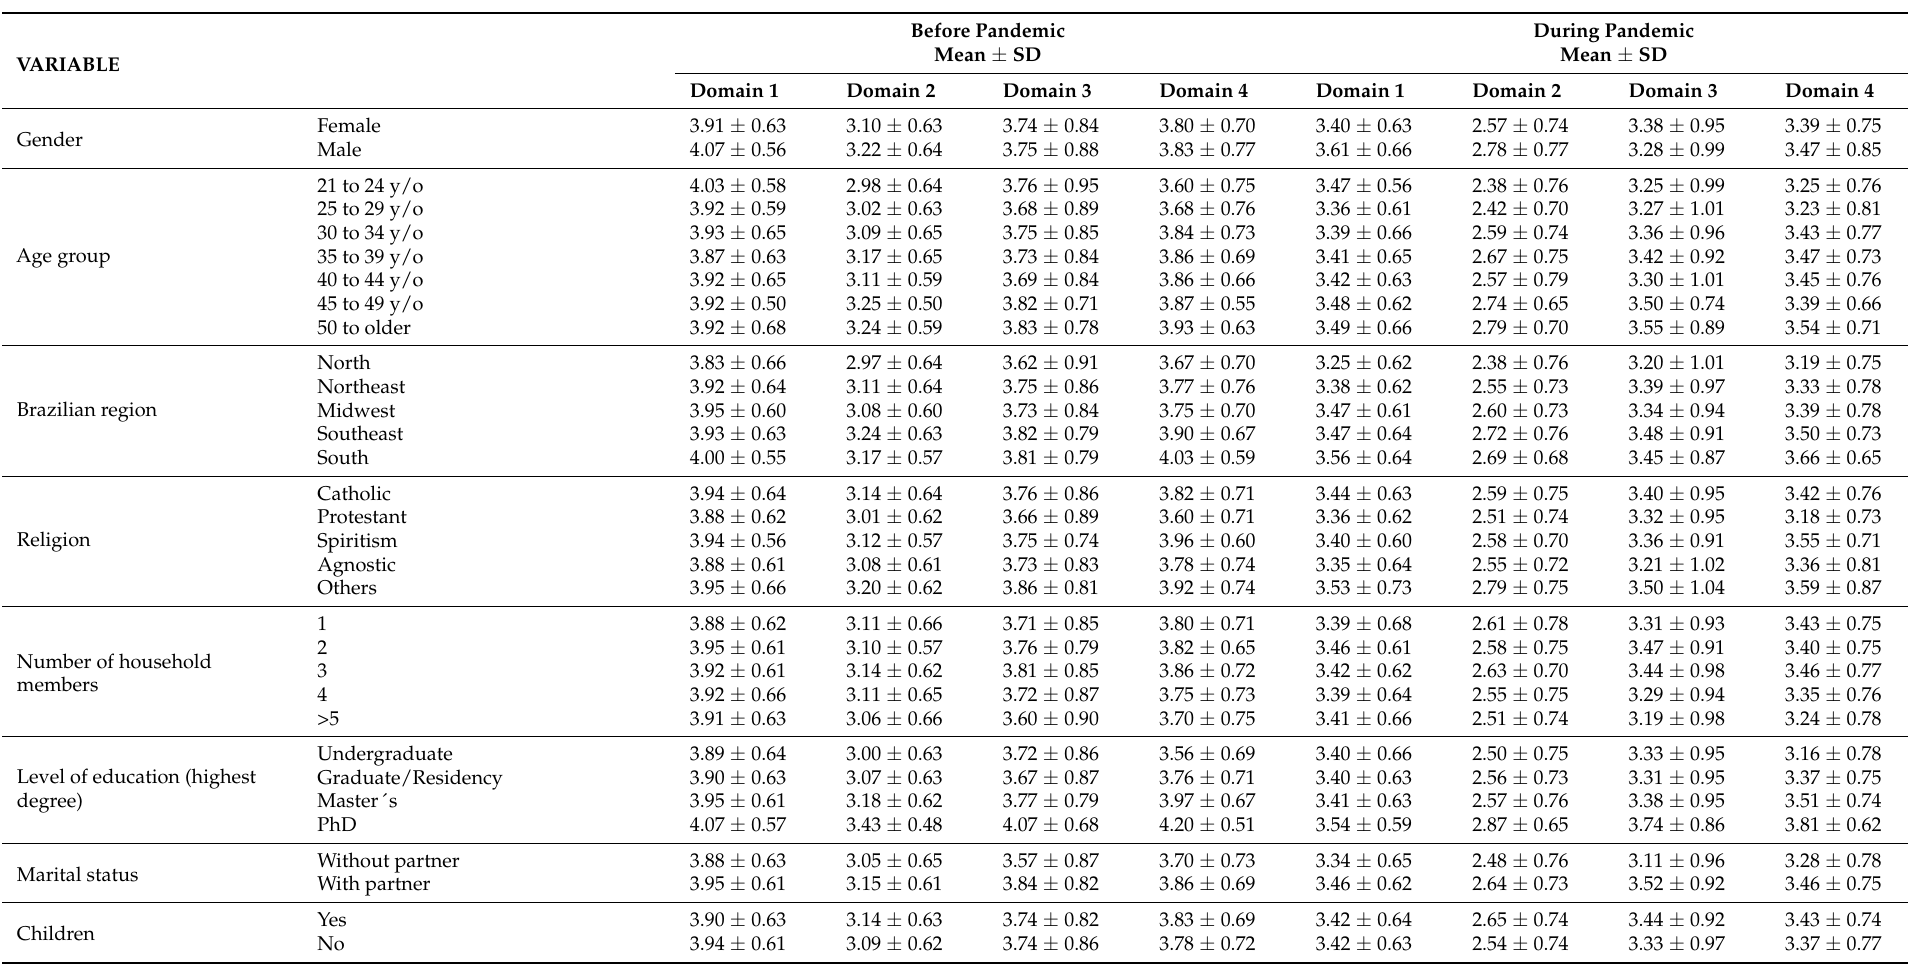
Table 3. Quality of life domains by socioeconomic and demographic variables of Brazilian dietitians before and during the pandemic period ( n =